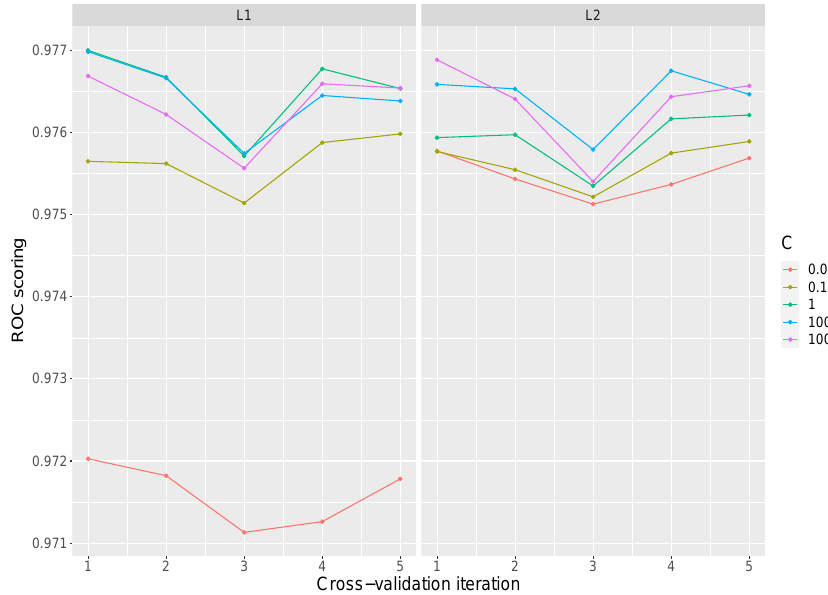
Figure 2. Logistic Regression mean scoring by